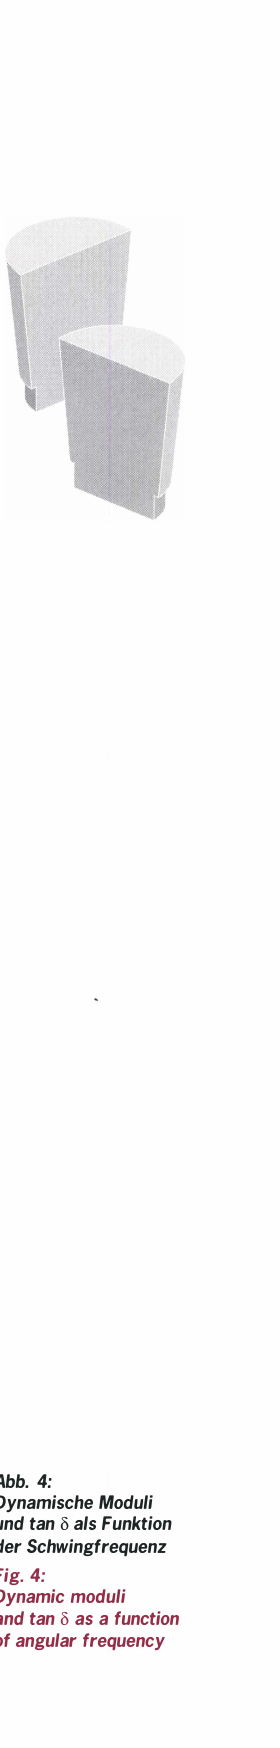
und tan o als Funktion der Schwingfrequenz Fig. 4: Dynamic moduli and tan o as a function of angular